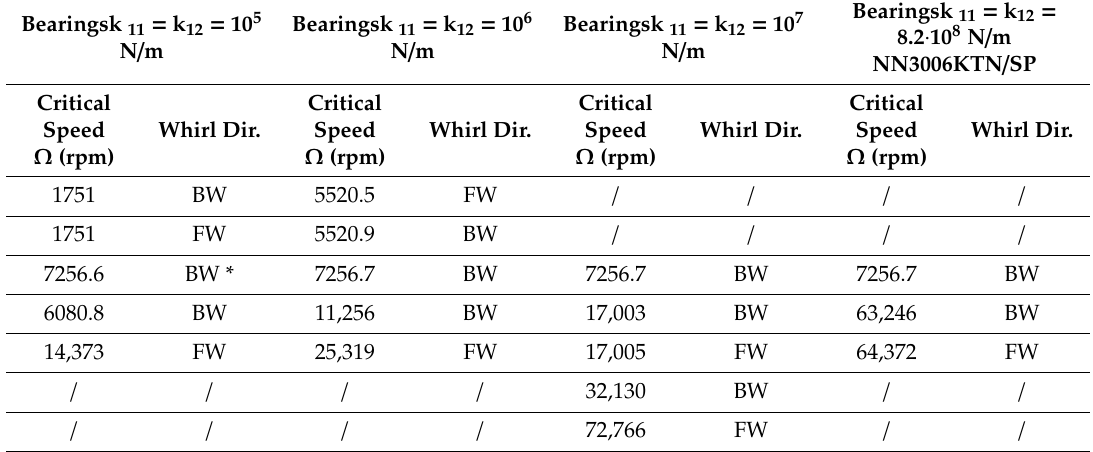
Table A1. Critical speeds of IPM rotor under the no-load